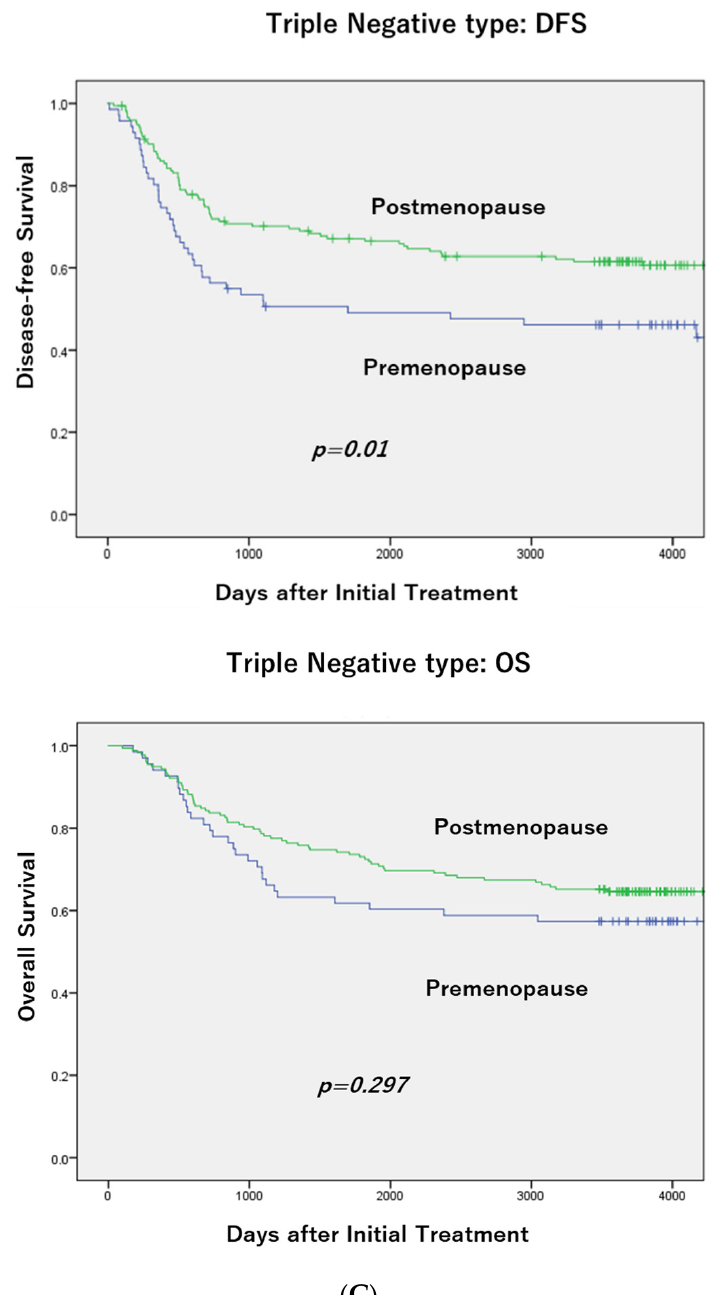
Figure 1. DFS according to Menopausal Status in Each Subtype and OS in TNBC. There was no difference in DFS between pre- and postmenopausal patients with the HER2 positive and Luminal A/B subtypes ( A , B ), but a significant difference ( p = 0.01) was seen in patients with TNBC (premenopausal patients had a poorer DFS than postmenopausal patients; ( C )). Moreover, postmenopausal patients had a more favorable OS than premenopausal patients, but the difference was not significant.